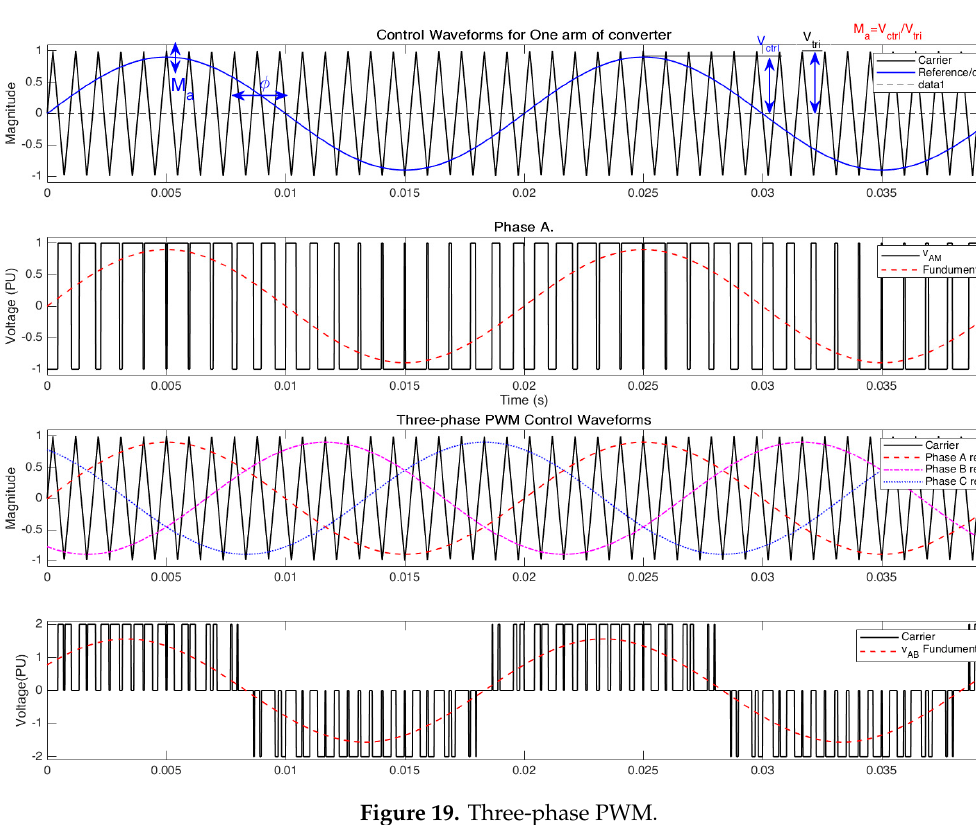
Figure 19. Three-phase PWM.